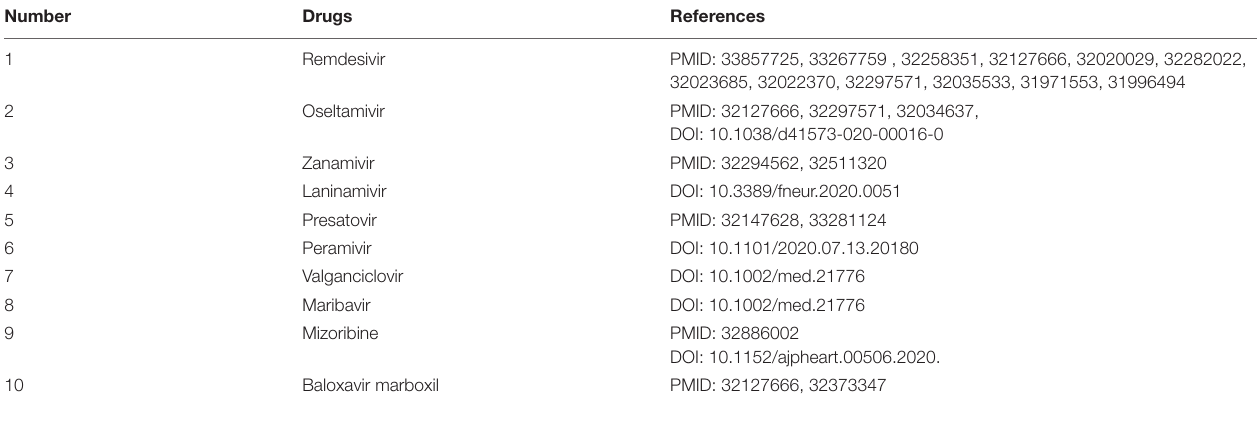
TABLE 5 | The predicted top 10 antiviral drugs against SARS-CoV-2 in dataset 1.